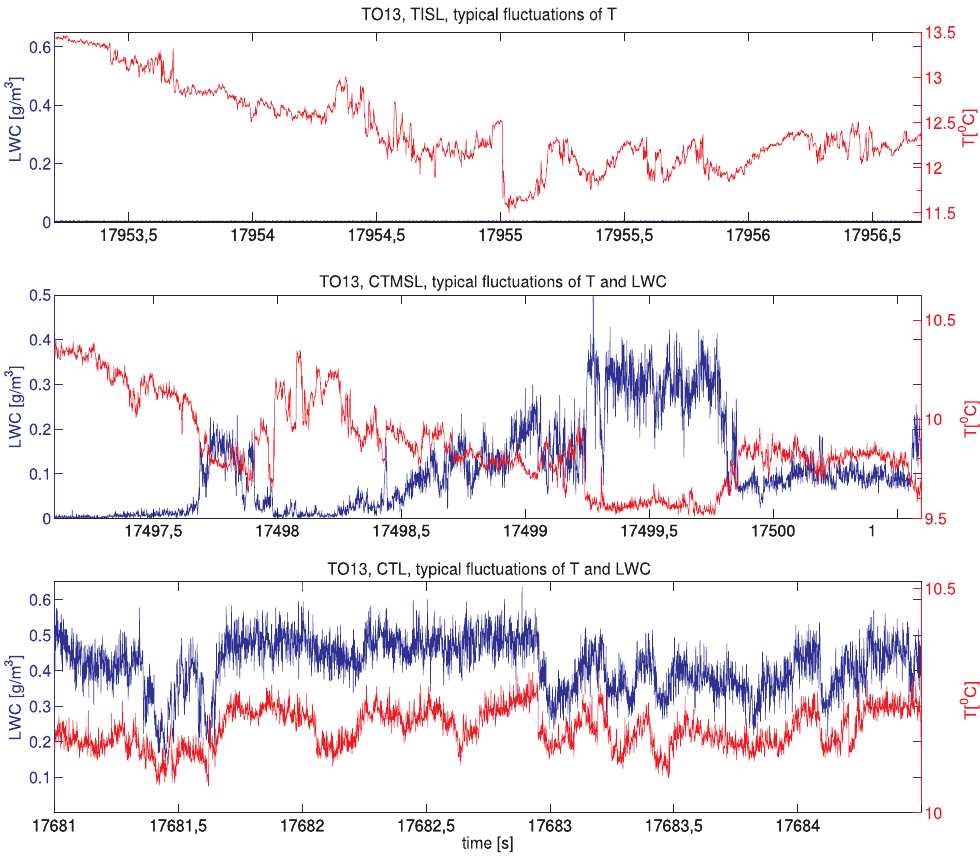
Fig. 7. As in Fig. 6 but for flight